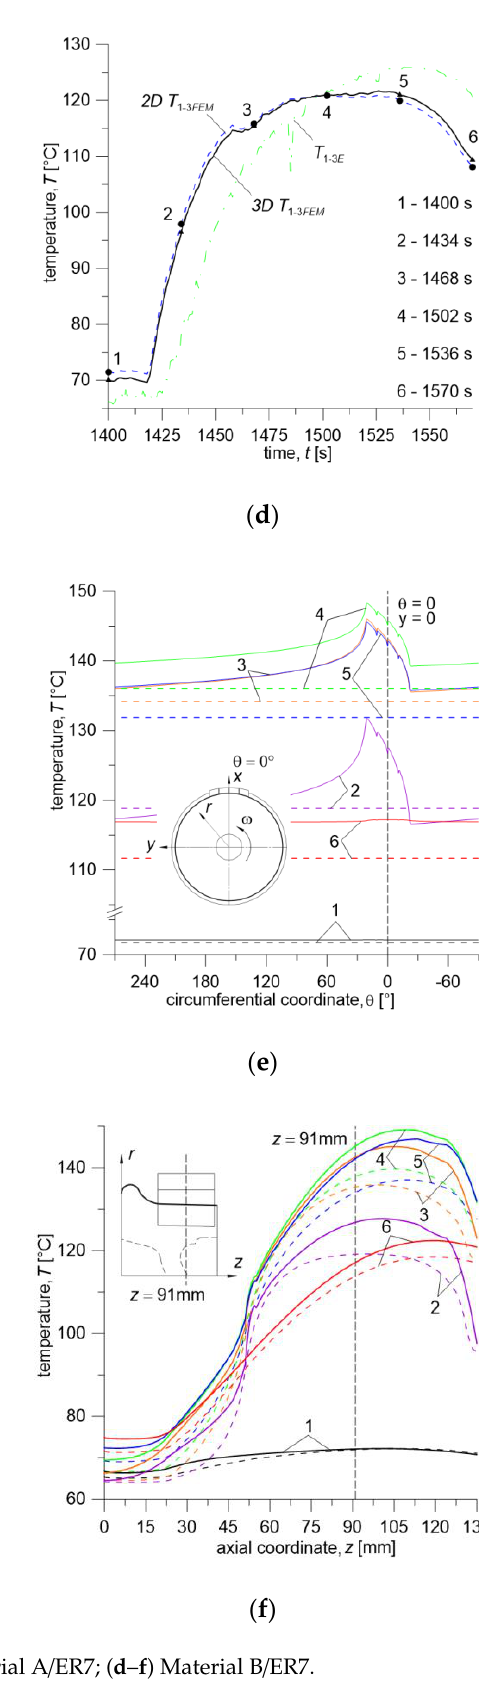
/ ER7; ( d – f ) Material B /